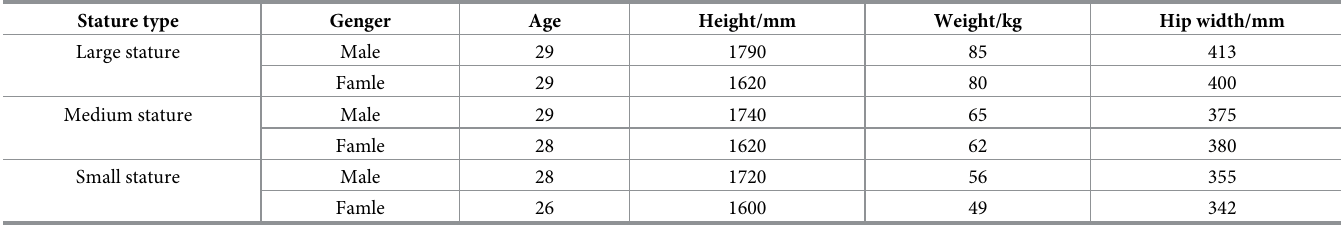
Table 2. Basic information of participants in Program 2. Stature